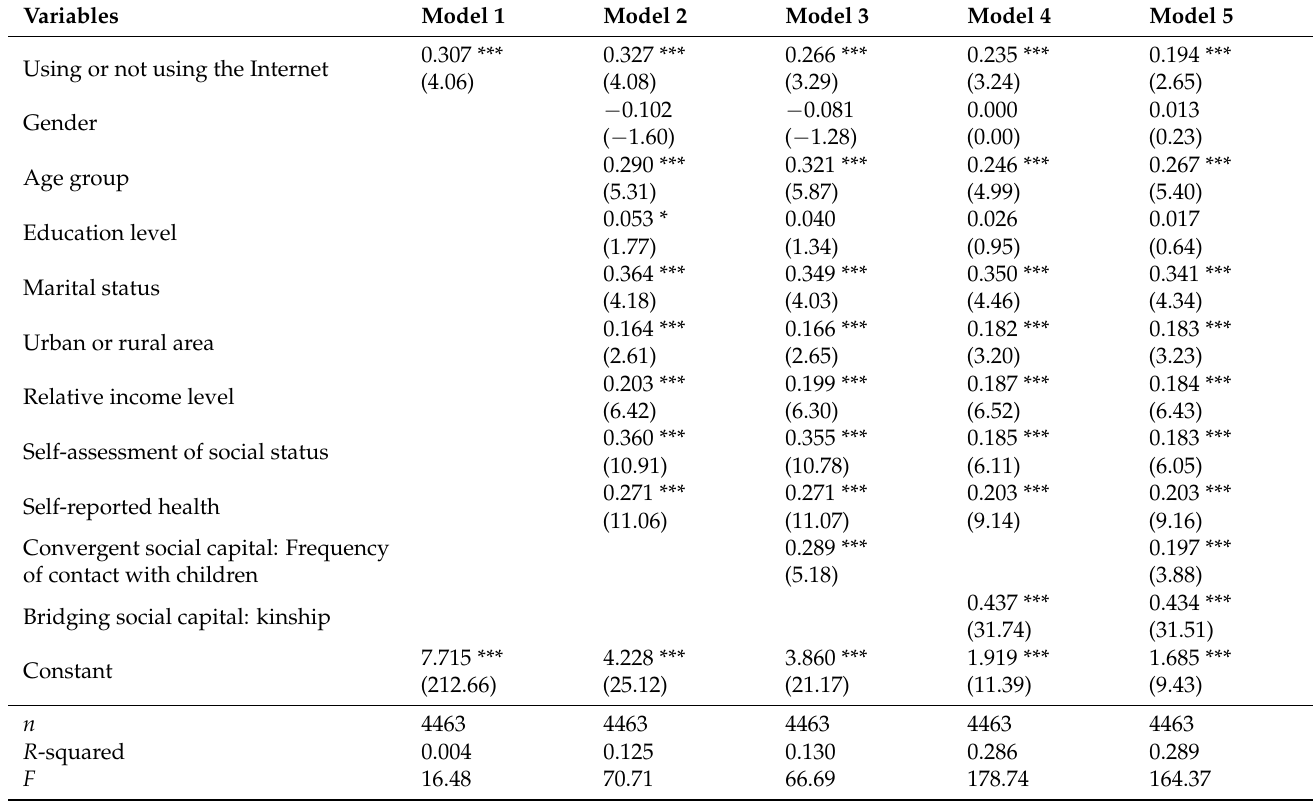
Table 2. OLS regression model of the influence of Internet use on the subjective well-being of the